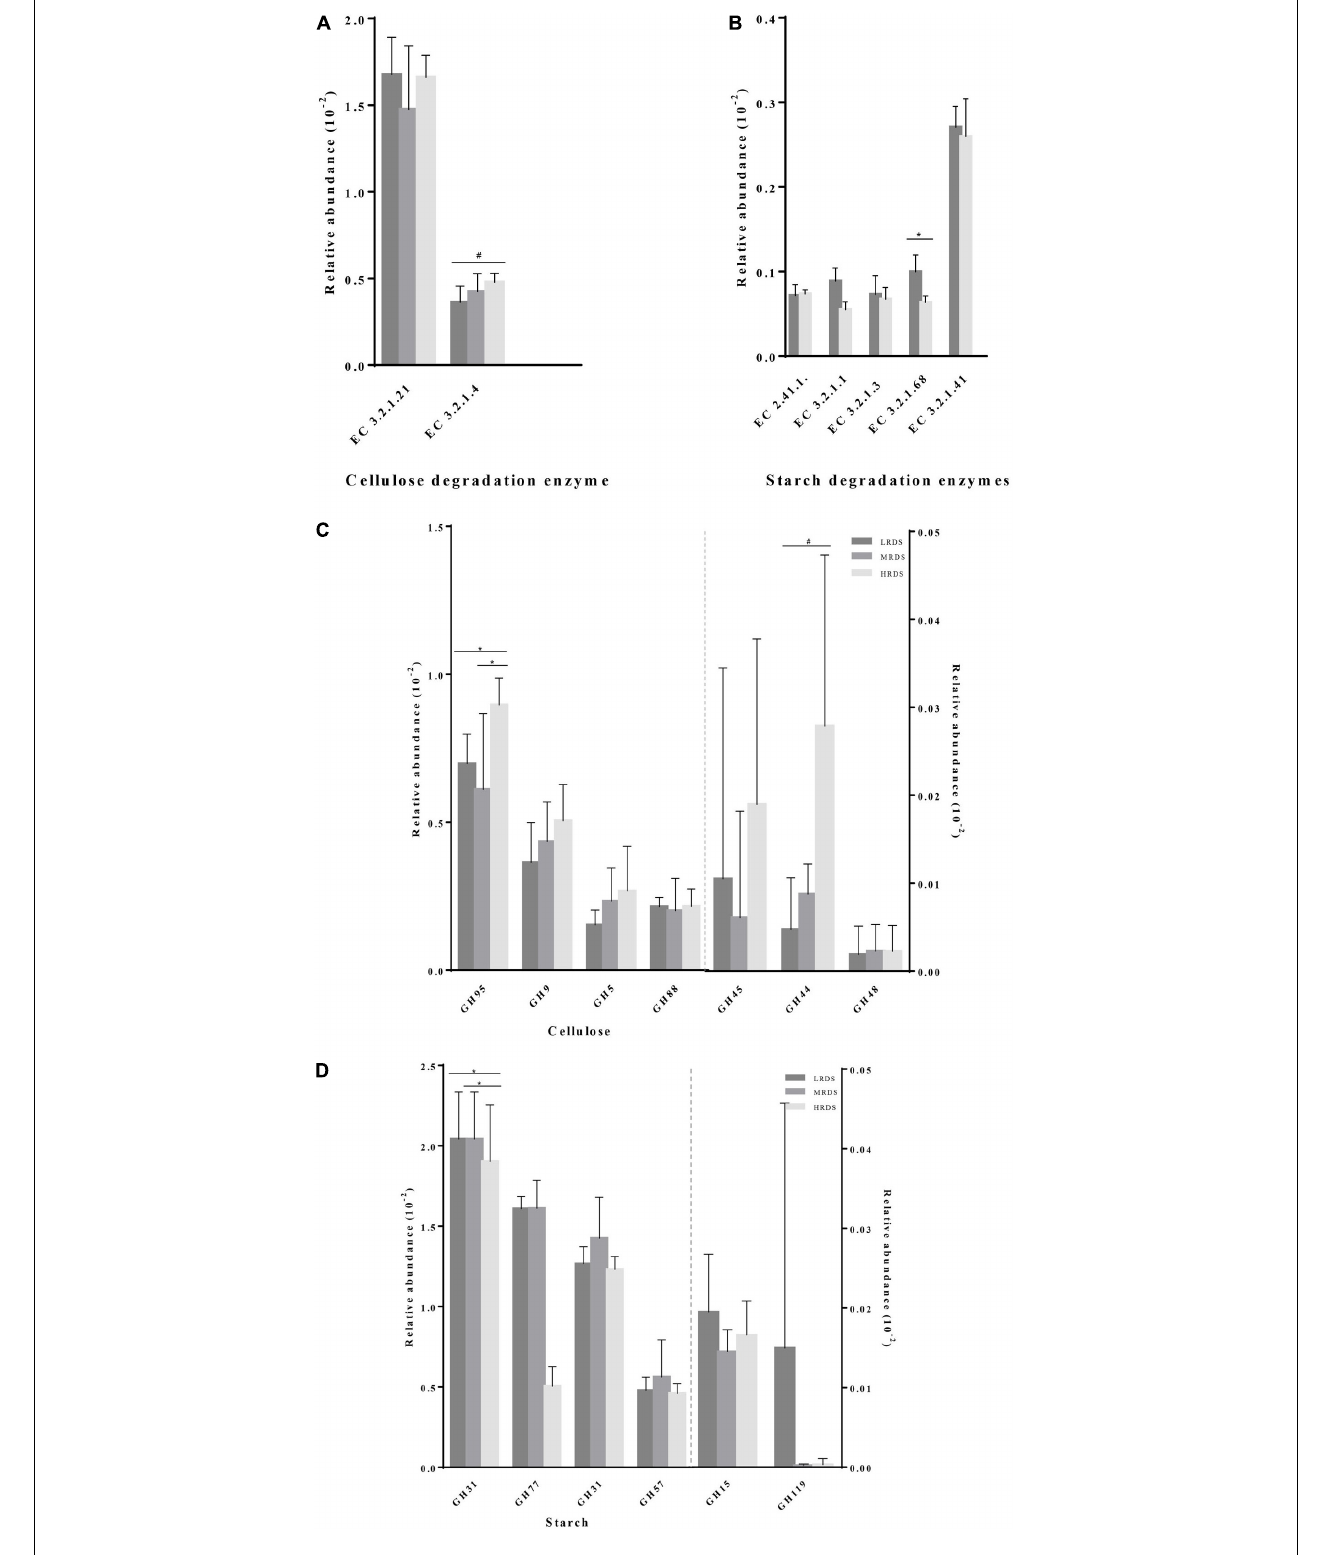
FIGURE 7 | Comparisons of the gene abundance of KEGG enzymes and GH family for (A,C) cellulase and (B,D) amylase.